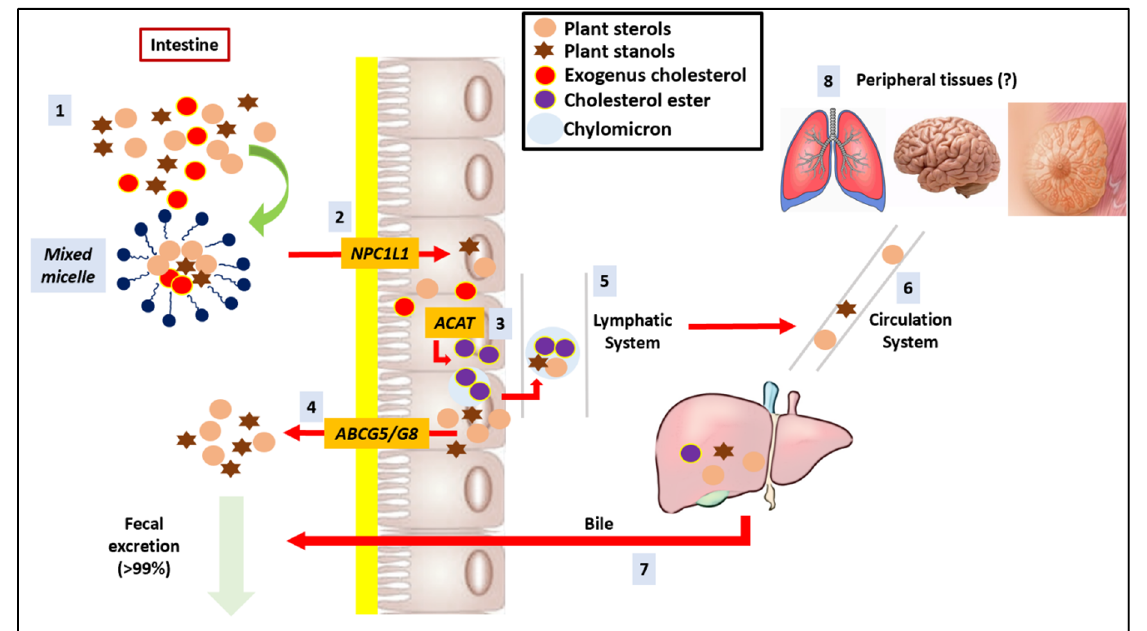
Figure 7. Plant sterol and stanol physiology. (1) PS arrive into intestinal lumen with exogenous cholesterol after a meal. (2) PS are taken up from the mixed micelles together with meal fats and bile and pancreatic secretions, which facilitate the entrance into enterocytes via the NPC1L1 transporter present on the brush border membrane of the enterocyte (3) Into enterocytes, while the cholesterol is a substrate for intestinal ACAT, PS are not easily esterified and thus not efficiently incorporated into chylomicrons (<1%). (4) PS are excreted back in the intestinal lumen through the ATP-binding cassette protein family ABCG5, and ABCG8 shuttles and is eliminated through the faeces with unabsorbed cholesterol. (5) A small percentage of PS is incorporated into chylomicrons and subsequently (6) reaches the bloodstream through the lymphatic system. (7) PS reach the liver, but most of the PS absorbed are re-excreted with the bile and thus eliminated through the faeces. Although circulating concentrations of PS are very low (6), they are probably taken up by several peripheral tissues in the brain, lungs and breasts